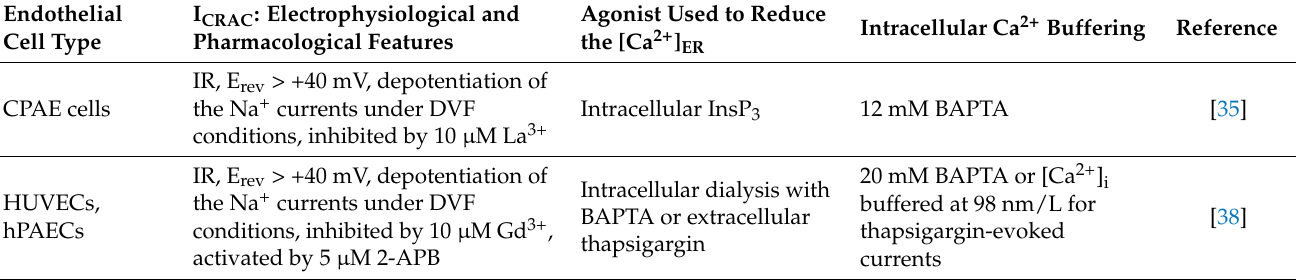
Table 2. Electrophysiological features of the endothelial I CRAC